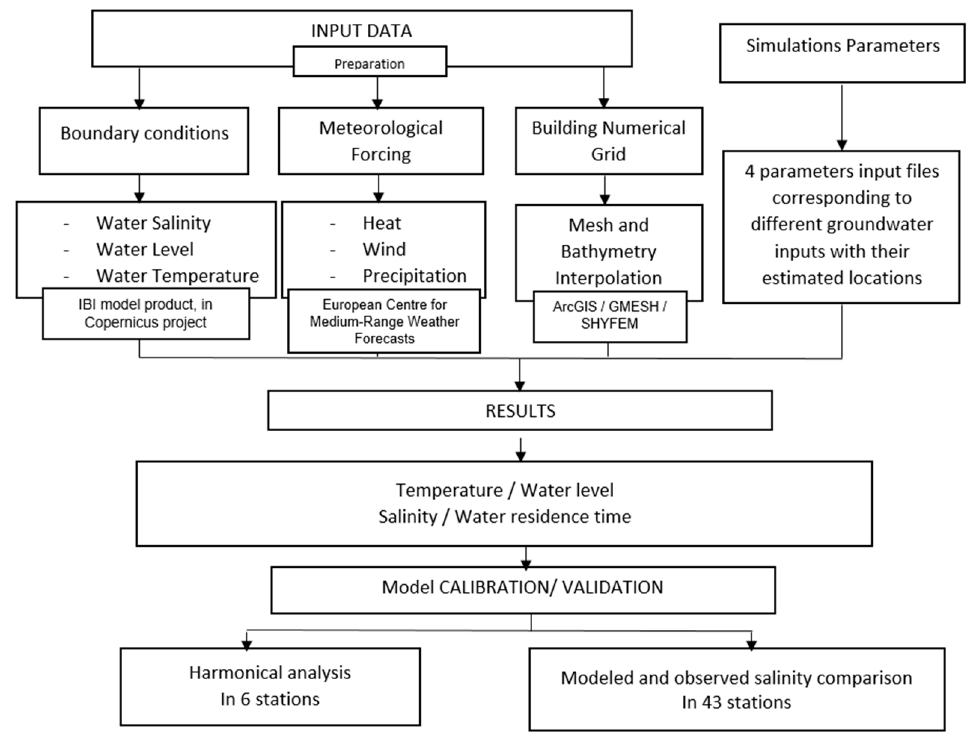
Figure 3. Framework/Methodology. Figure 3.